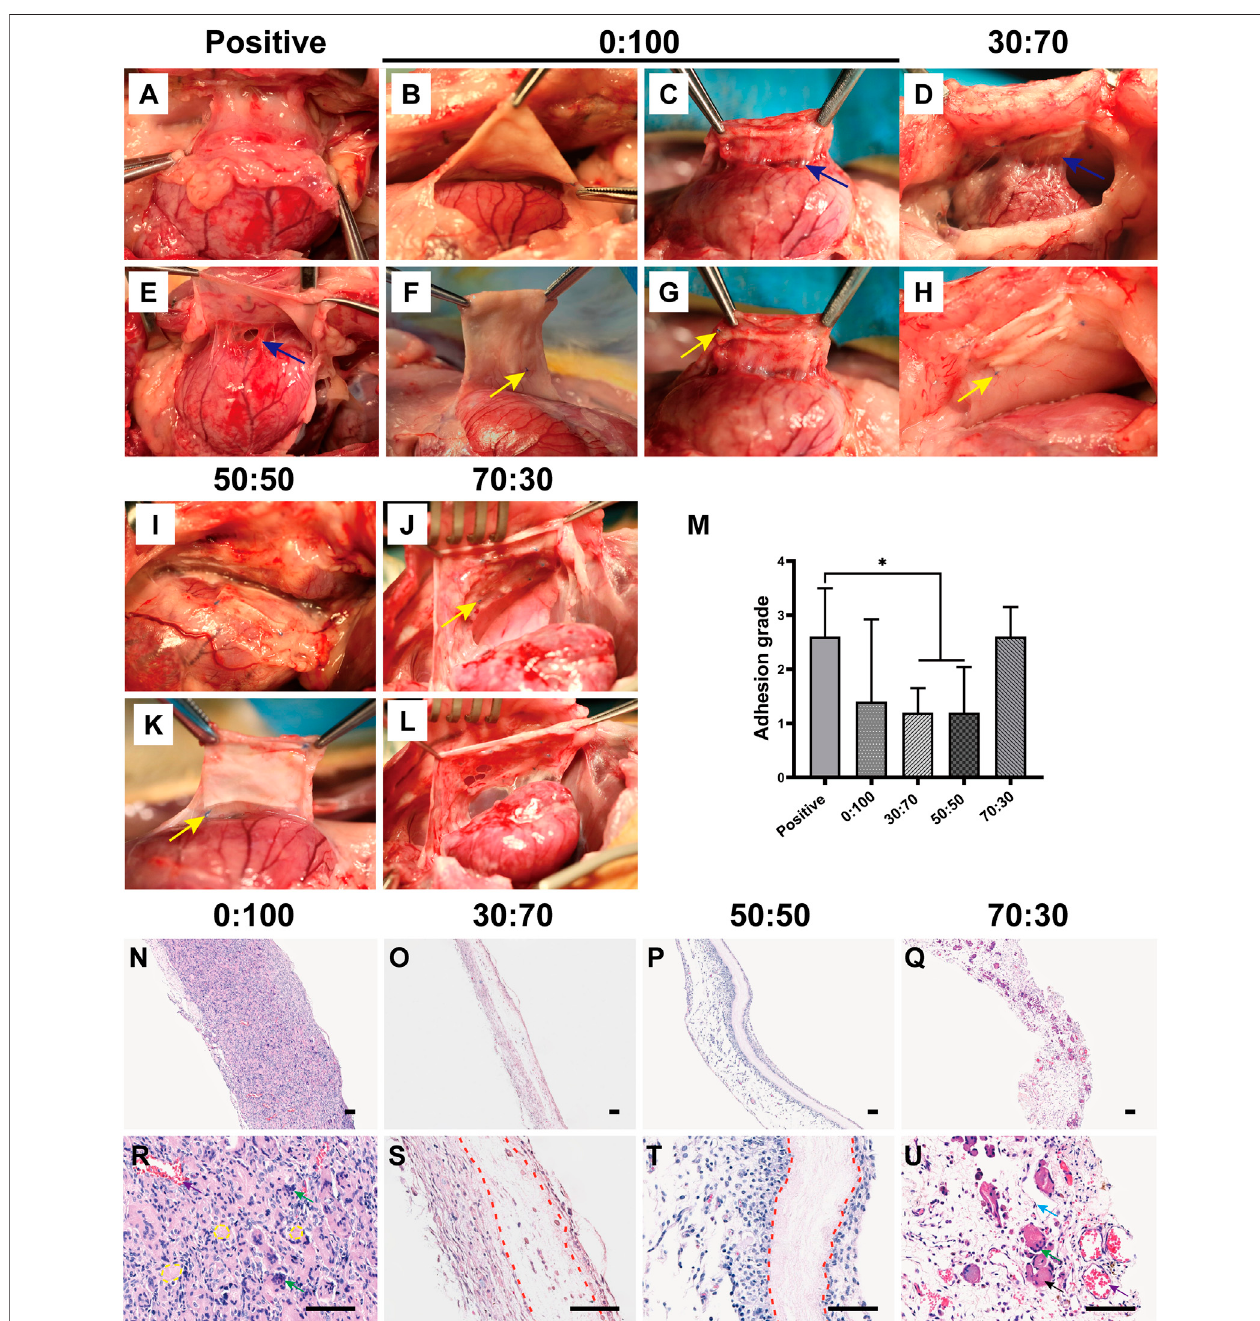
FIGURE 7 | One month after surgery representative overall images for (A,E) positive control, (B,C,F,G) 0:100, (D,H) 30:70, (I,K) 50:50, and (J,L) 70:30 groups, blue arrows indicate adhesion sites, and yellow arrows show sutures positions. (M) pericardial adhesion grades, * p < 0.05, and representative H-E staining images for (N,R) 0:100, (O,S) 30:70, (P,T) 50:50, and (Q,U) 70:30 groups, yellow circles indicate “ islands, ” red dot lines indicate “ barriers. ” Green, blue, black, and purple arrows show multinucleated giant cells, fi broblasts, muscular tissues, and blood vessels, respectively. Scale bars (cid:1) 80 μ